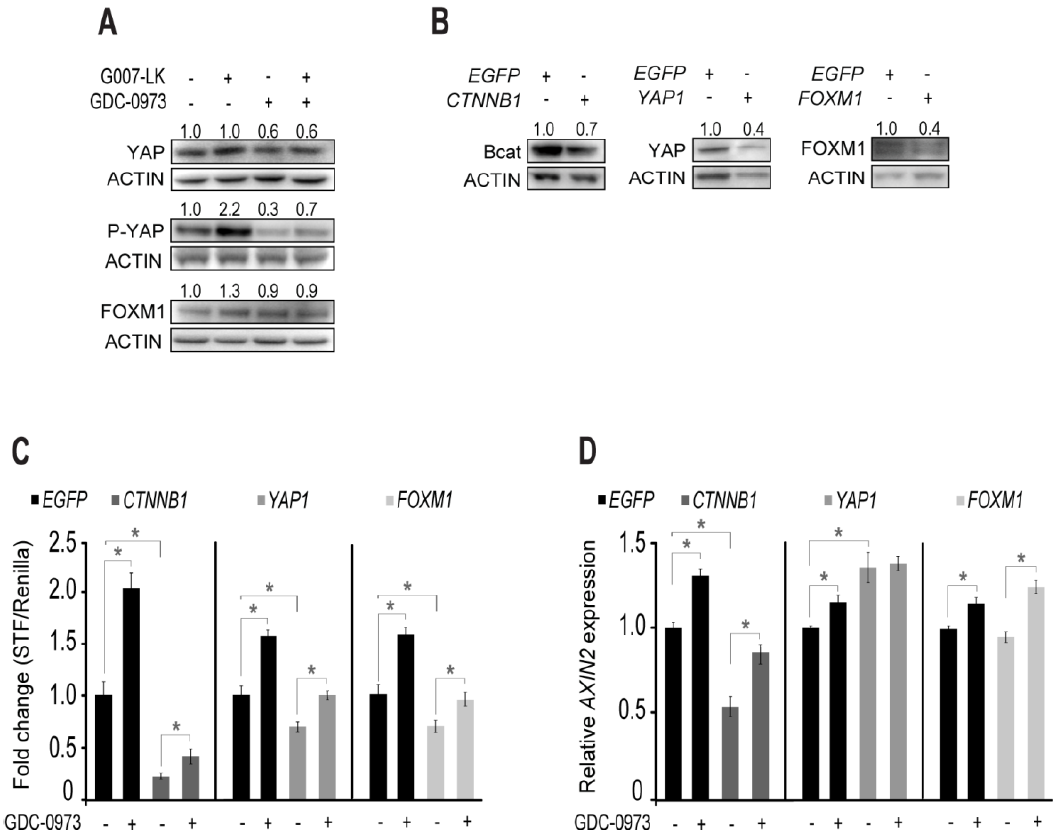
Figure 6. Feedback activation of YAP is responsible for enhanced AXIN2 transcription upon MEK inhibition in HCT-15 cells. Regulations of YAP, P-ser127 YAP (P-YAP) and FOXM1 protein levels in total cell extracts from HCT-15 cells after 24 h incubation with inhibitors as indicated ( A ). Numbers above blots indicate volume measurements of Protein/ACTIN band intensity, and relative to the DMSO control. Western blot analysis showing total β -catenin (Bcat), YAP and FOXM1 protein levels after esiRNA mediated knock down (KD) of β -catenin, YAP and FOXM1 ( B ). Individual KD data is compared to their respective EGFP controls. Luciferase reporter assay ( C ) and AXIN2 transcription levels ( D ) were measured on esiRNA mediated KD cells after 24 h of treatment with DMSO control media or MEK inhibitor containing (1 µ M GDC-0973) media as indicated. All KD related assays were conducted on HCT-15 cells stably transfected with SuperTop-Flash (STF) and Renilla plasmids. Gene transcription levels were normalized to internal GAPDH levels prior to their relative comparison to the DMSO control. All experiments shown are performed in parallel and are representative graphs/immunoblots from at least 3 independent experiments. Bars in ( B – D ) indicate mean relative expression values ( ± STDEV) from at least 3 technical replicates. * p < 0.05.